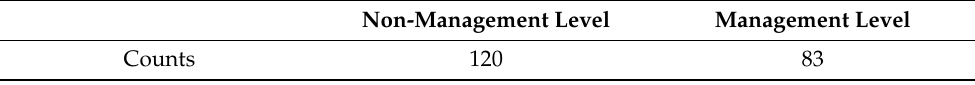
Table 7. The distribution of staff by their rank in the